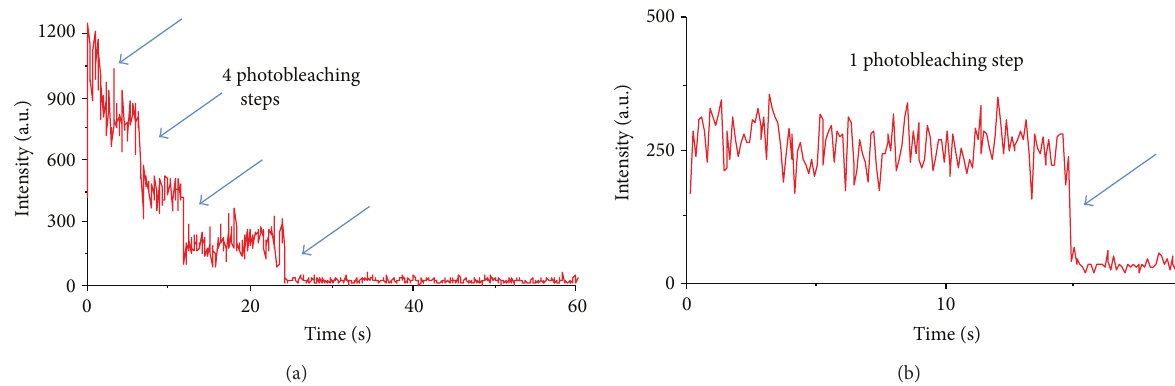
Figure 9: Multiple photobleaching steps in SiMPull experiments with rpl18p-SNAP strains (a) indicate multiple immobilized proteins as compared to pure SNAP protein which shows only single photobleaching step (b).